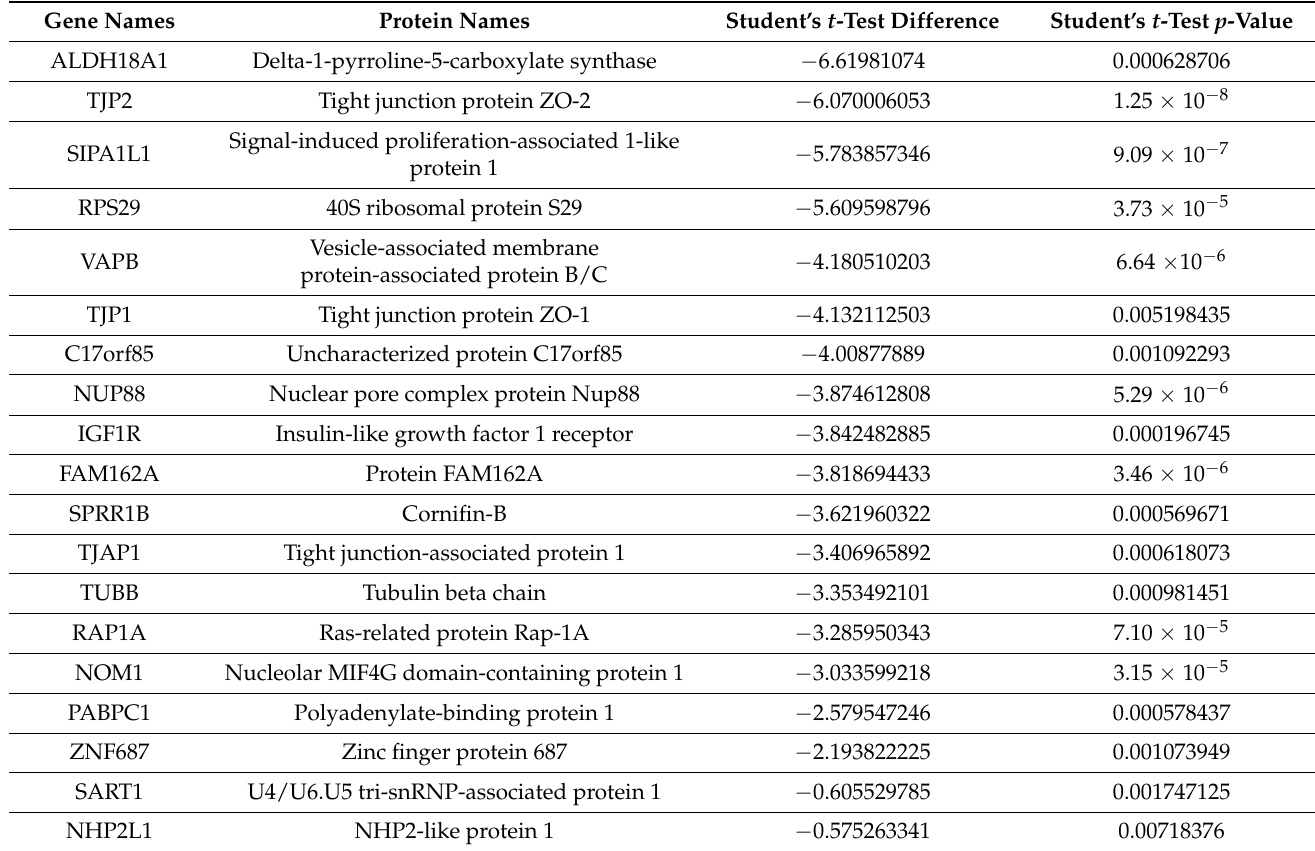
Table 1. Nuclear IGF1R interactors in breast cells. Nuclear extracts of benign MCF10A cells were immunoprecipitated